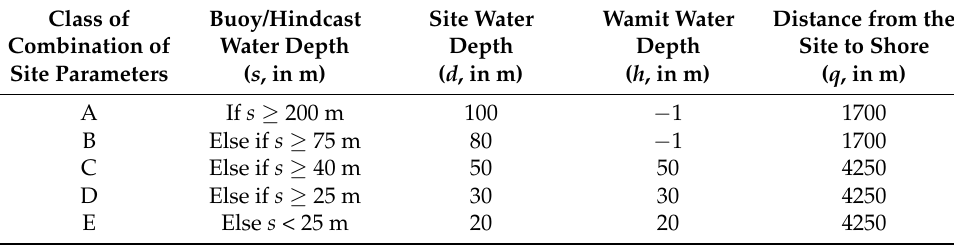
Table 3. External parameters relationship of the